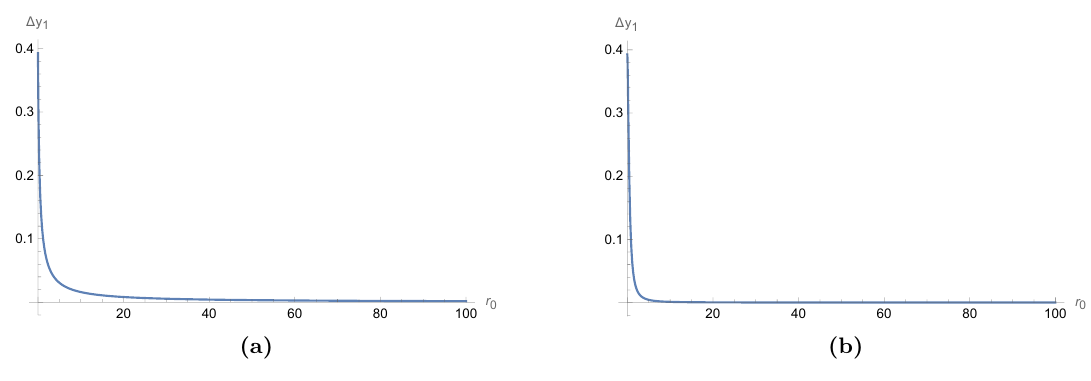
Figure 1. r UV = 10 4 , n = m = α = β = 2 . (a) δ = 1 , (b) δ = 2 . The maximum value in both cases is the same and agrees with analytical result